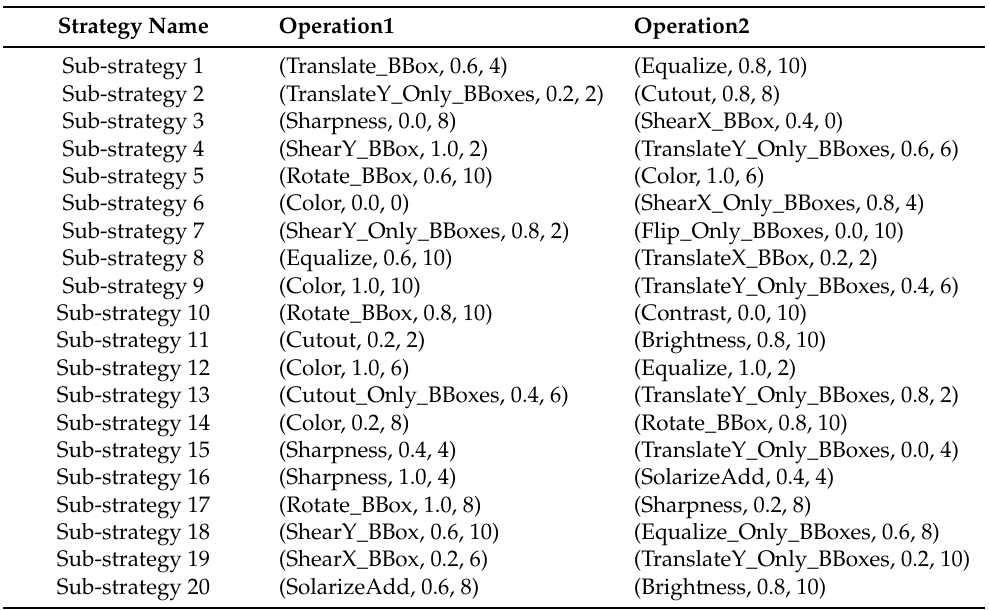
Table 1. Examples of learned augmentation sub-strategies. Each operation in an augmentation sub-strategy is represented by a triplet: the operation, its likelihood of being used, and its